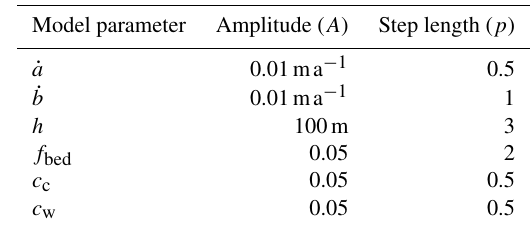
Table 4. Perturbation amplitude ( A ) and step length ( p ) of the in- dividual model parameters used for the Monte Carlo sampling. The sampling parameters were chosen such that the acceptance ratio of the individual model parameters lies between 25% and